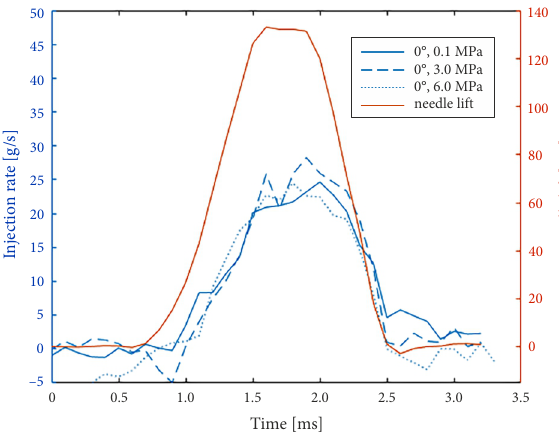
Figure 7. Measured injection rates and needle lift for 1500 min –1 , 100 N ⋅ m, 0° plug valve state, with different